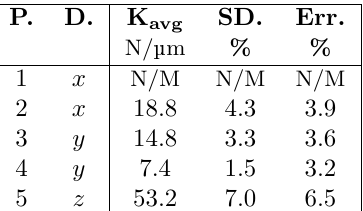
Figure 19: 2-axis trunnion: deflection measurement at first load application (position 3) (R).